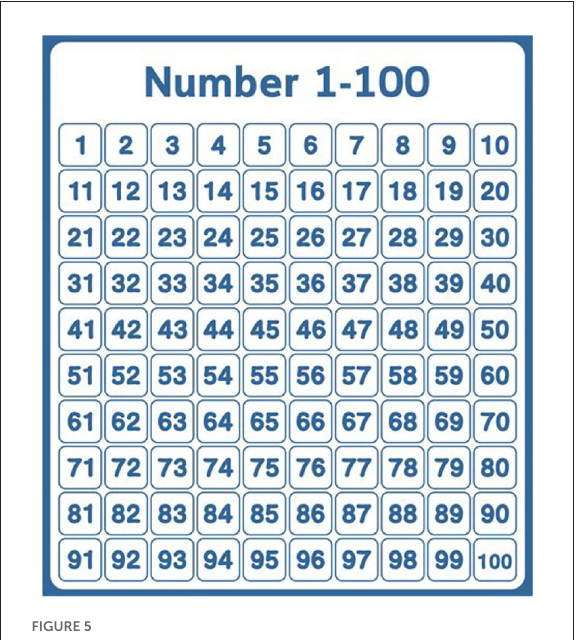
FIGURE5 An example of an educational number chart